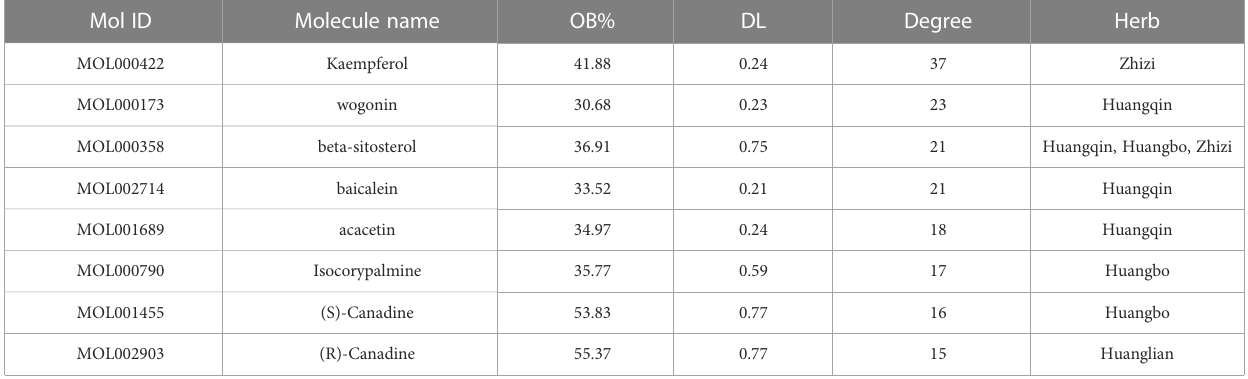
TABLE 1 Chemical information sheet of major active